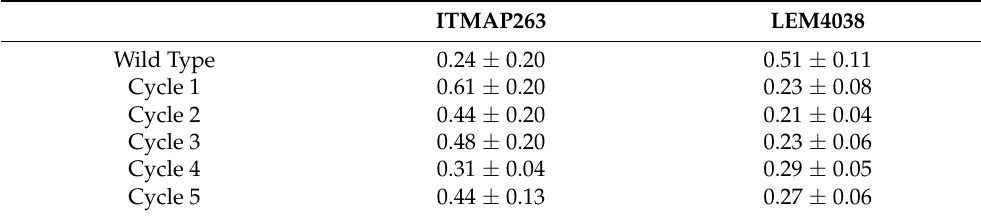
Table 1. In vitro susceptibility of intracellular amastigotes to DNDI-6148 after each in vitro selection cycle. Results are expressed as the mean EC 50 ( µ M) ± standard mean of error (SEM) and are based on two biological replicates, each consisting of two technical